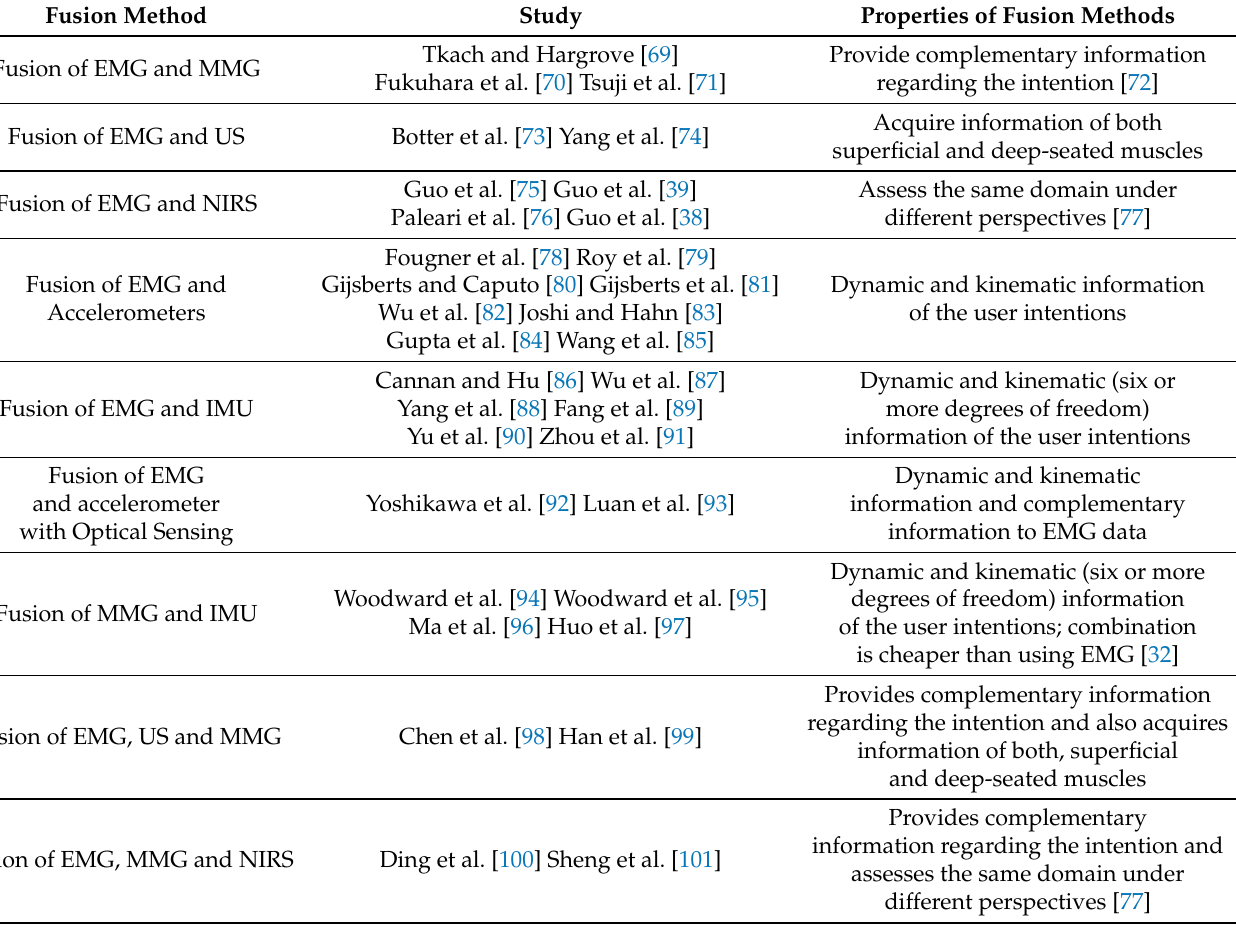
Table 2. Myography fusion methods explored in the studies included in the systematic